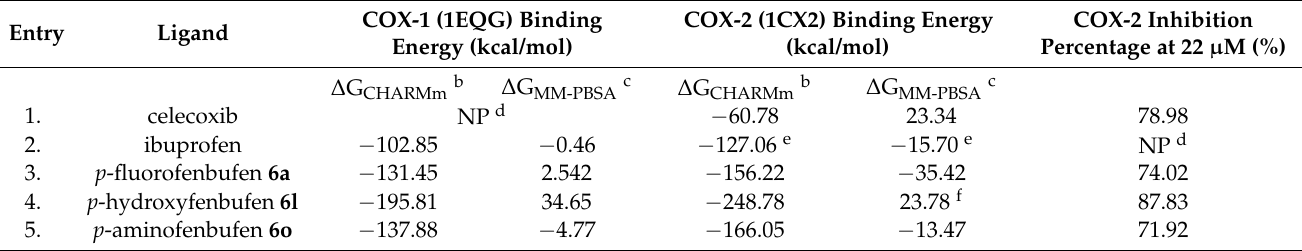
Table 2. Comparison of Gibbs free binding energies (kcal/mol) a and COX-2 inhibition of three potential p -substituted fenbufen analogs 6a , 6l , 6o , along with benchmark inhibitors celecoxib and